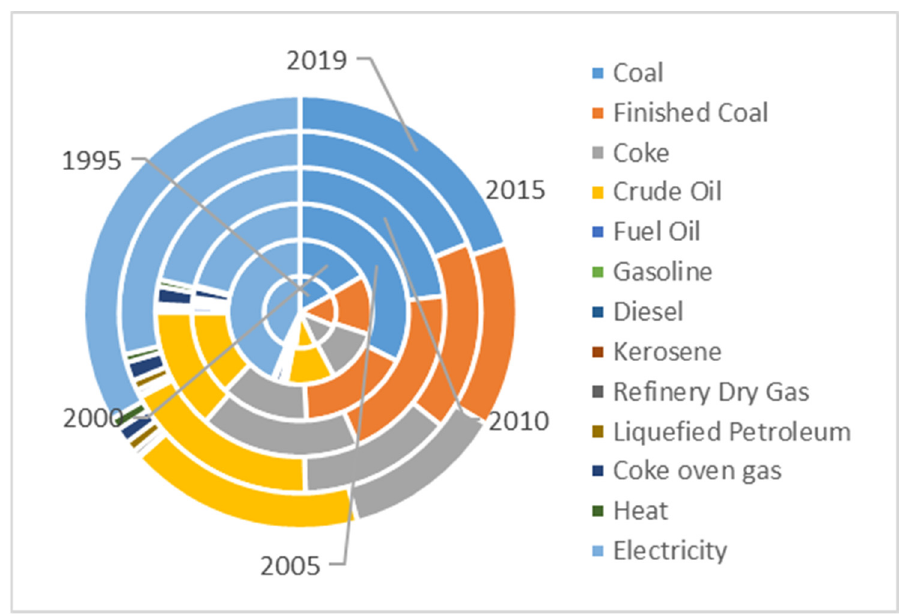
Figure 4. Energy consumption ratio in Wuhan, 1995–2019.